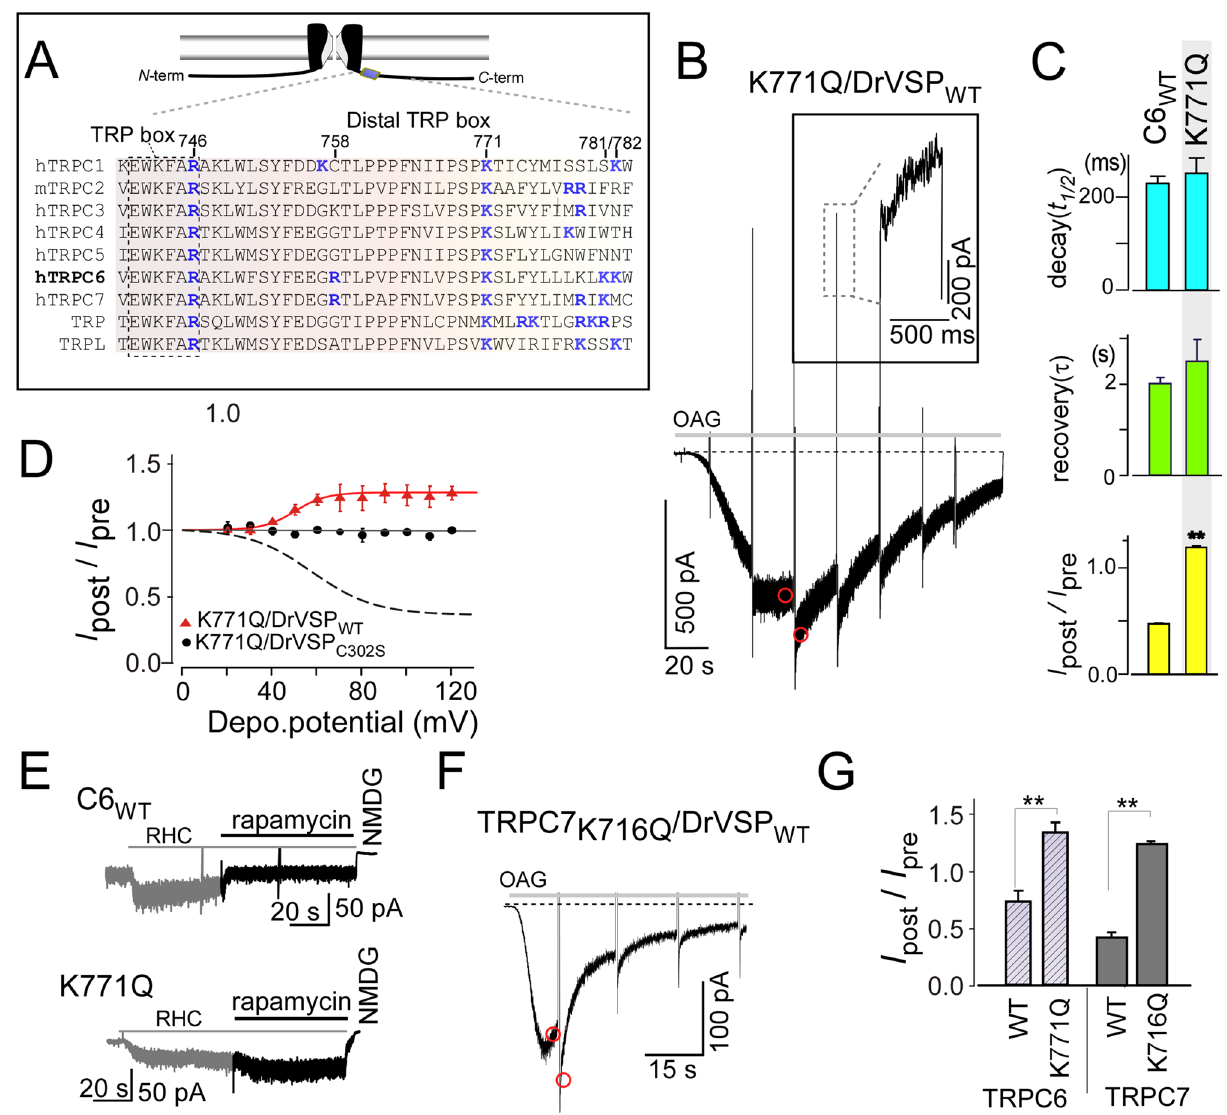
Figure 7. K771Q mutation reversed the effect of PIP 2 depletion. ( A ) Sequence alignment of TRP box to distal TRP box in human TRPC/drosophila TRP channels. Numbering corresponds to hTRPC6 amino acid sequence. Critical basic residues for PIP 2 regulation are indicated in blue bold. ( B ) 50 μM OAG-induced currents recorded from HEK297 cells expressing K771Q and DrVSP WT . The inset shows an enlargement of the outward current. ( C ) Summary of deactivation (top), reactivation (middle) kinetics, and I post / I pre (bottom) (for K771Q n = 5). ( D ) Result of the voltage-step protocol with K771Q and DrVSP WT showed in red circles. Depolarizing pulses were stepped from 0 to + 120 mV in 10-mV increments. Black circles depict the ratio of I post / I pre from VSP mutant DrVSP C302S with K771Q. These results indicate no visible voltage-dependent activation and PIPs selectivity alternation effect which is reported in Ci-VSPs 38,39 . The dashed line shows response with TRPC6 WT /DrVSP WT (data is identical to Fig. 3D). ( E ) Response to rapamycin (10 μM)-induced PIP 2 reduction in cells expressing TRPC6 WT (top) and K771Q (bottom). Currents were evoked by RHC-80267 (100 μM) (F) TRPC7 K721, which is the equivalent amino acid to K771 in TRPC6, mutation (K721Q) potentiated the channel opening upon DrVSP activation. OAG (50 μM) was applied to induce the currents. ( G ) Summary of the polarity switch induced by rapamycin (diagonal line bars, n = 4, respectively) on TRPC6 channels and by effect of DrVSP WT on TRPC7 K721Q (gray bars, n > 4). ** p <